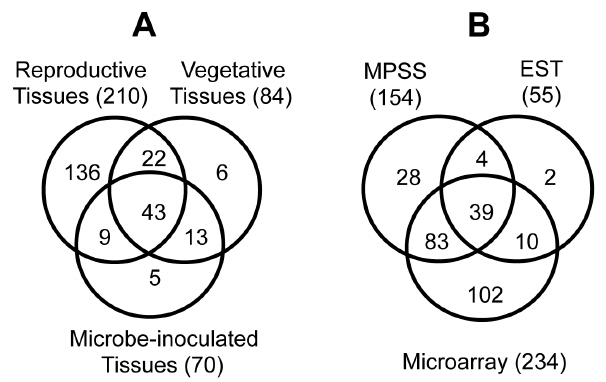
Figure 3. Venn diagrams of expressed Arabidopsis DEFL s in different treatments. A, Number of expressed DEFL s and MEG s in various tissues. B, Comparison of different gene discovery approaches for the number of identified expressed DEFL s by each technique.